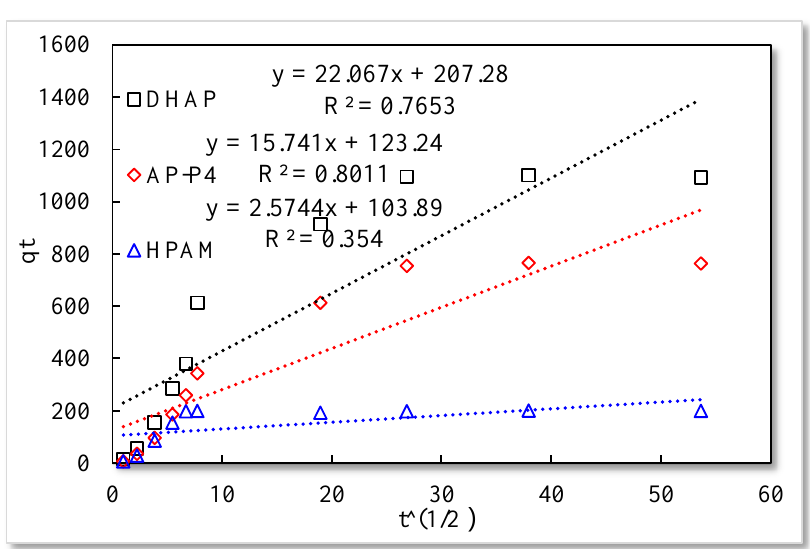
Figure 9. Pseudo − first − order kinetic model.